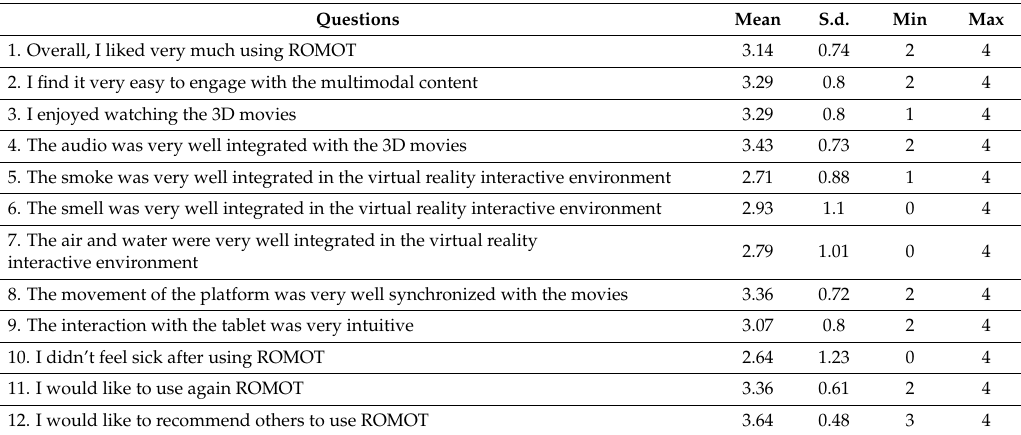
Table 3. Results of the individuals’ satisfaction questionnaire (mean, standard deviation, minimum, and maximum).